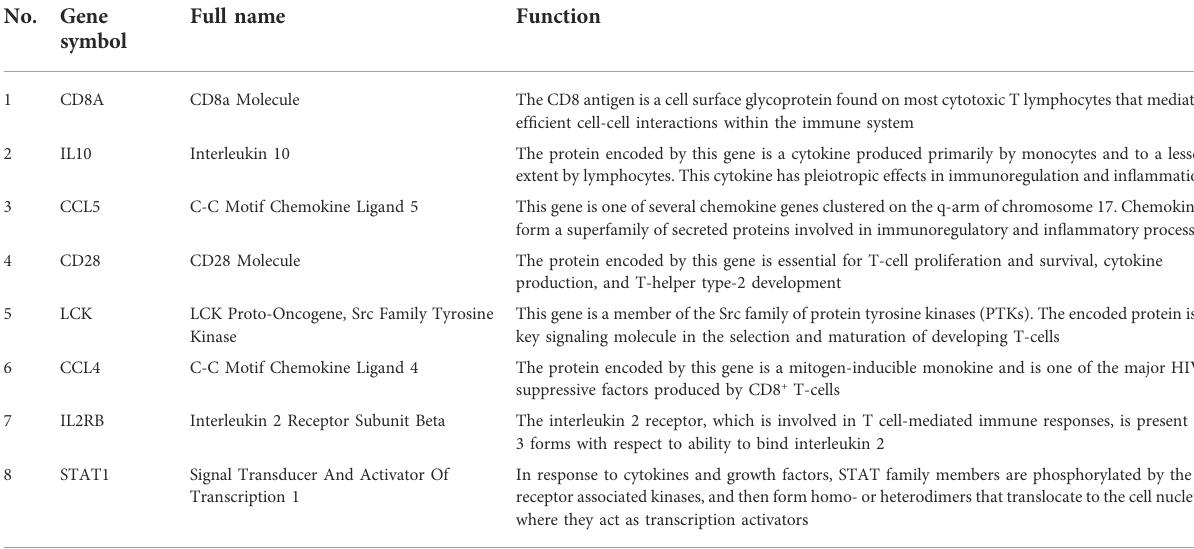
TABLE 2 The details of the core immune-related